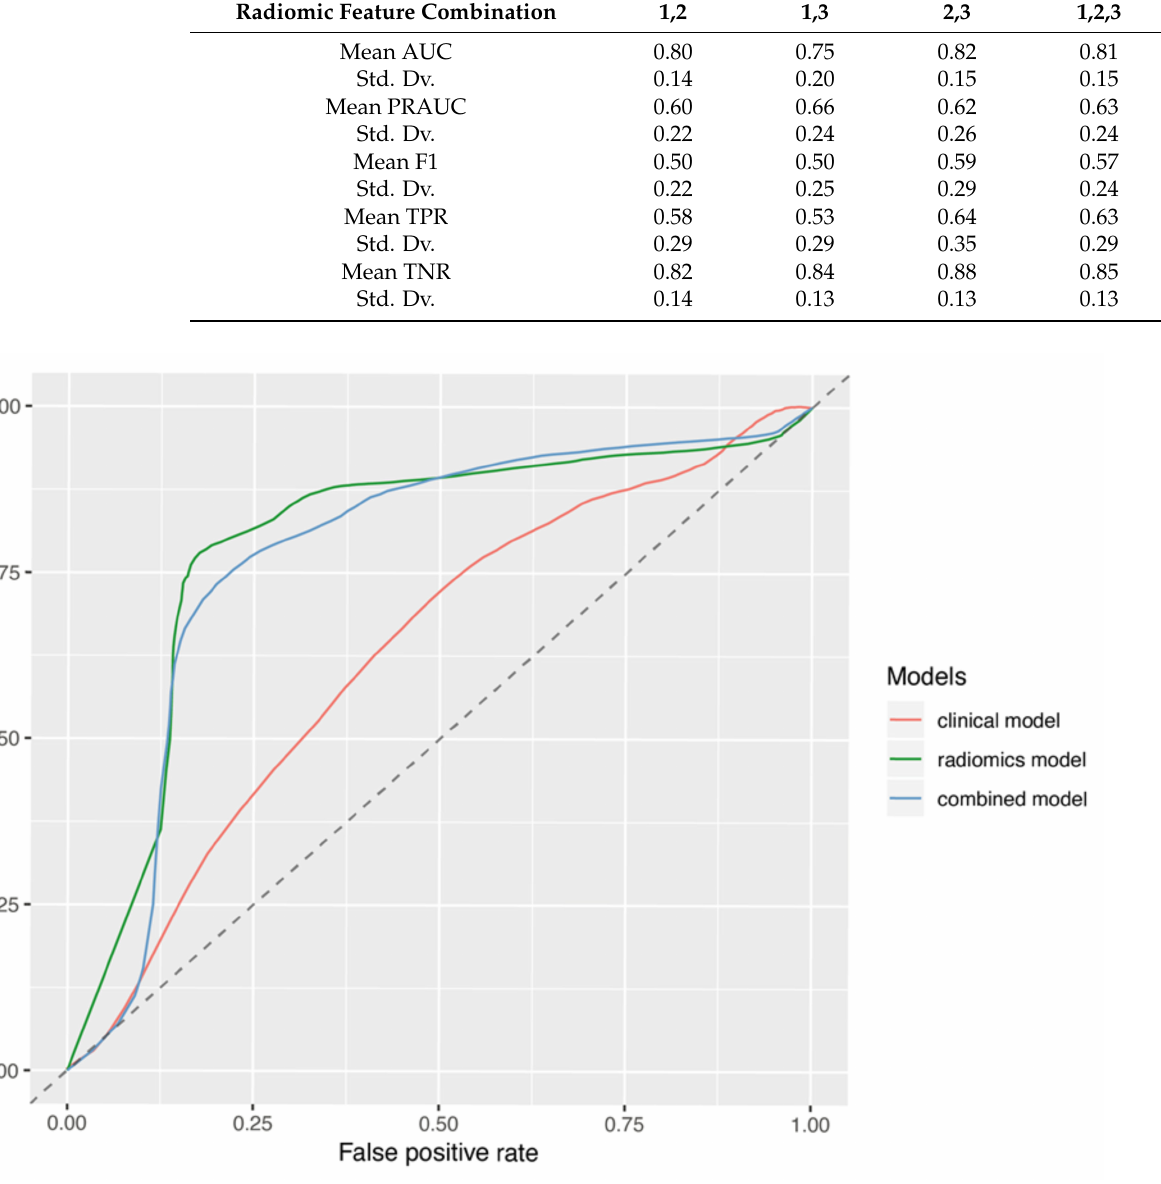
Figure 2. The average ROC curves of the selected radiomics model, the clinical model, and the combined model with both radiomic and clinical features, generated from the 3000 cross-validation datasets. The mean AUC was 0.62, 0.82, and 0.80 for the clinical model, the radiomics model, and the combined model,